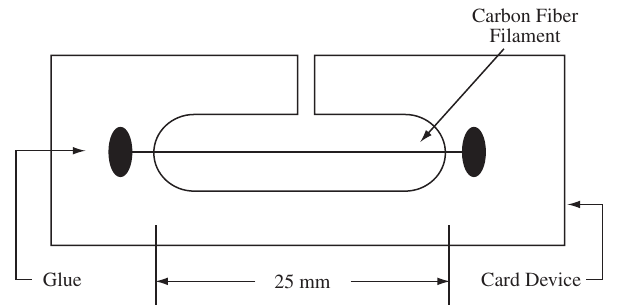
Figure 1. Schematic of the cardboard fixture for single filament testing.